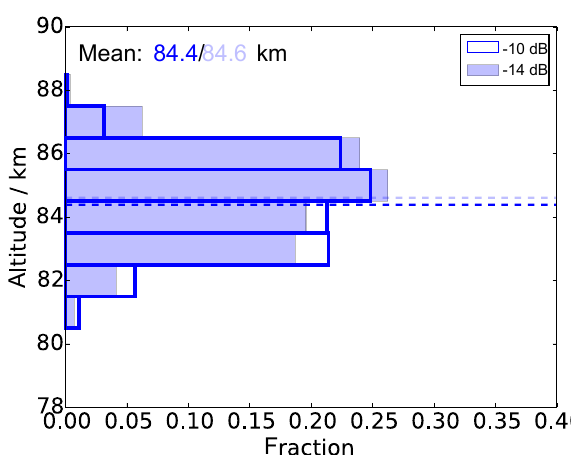
open bars show the MSE threshold SNR of − 10dB; light blue filled bars show the MSE threshold SNR of −